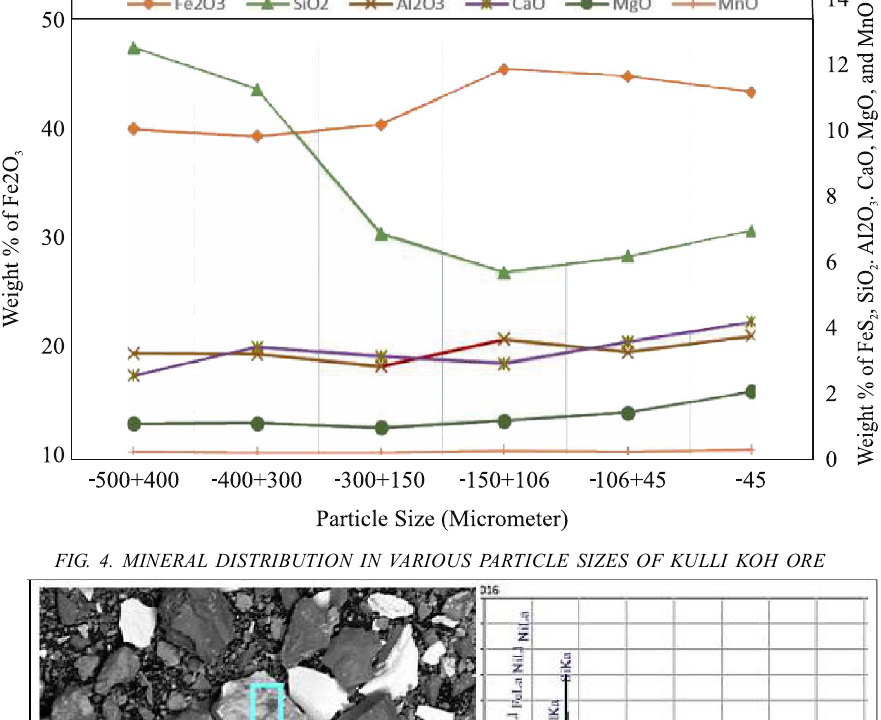
FIG. 4. MINERAL DISTRIBUTION IN VARIOUS PARTICLE SIZES OF KULLI KOH ORE